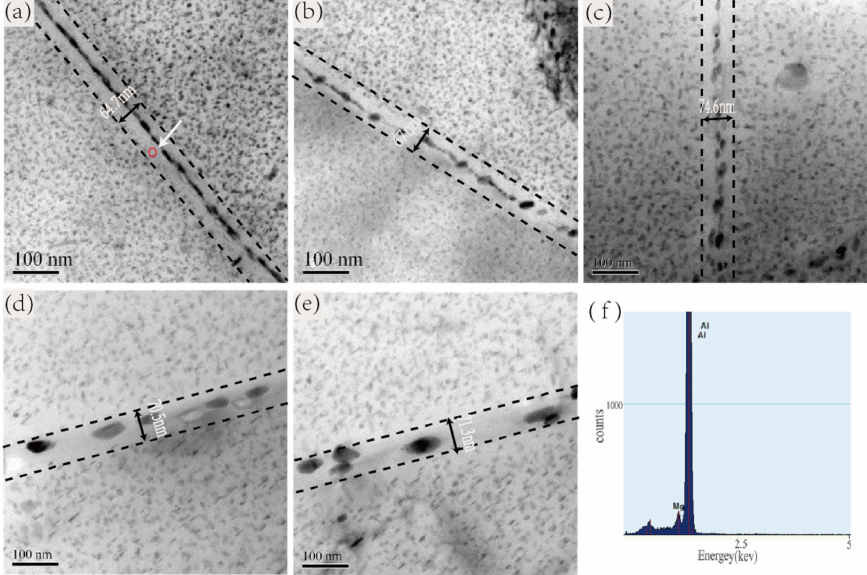
Figure 4. Grain boundary precipitation phase of the alloys: ( a ) Alloy 1, aging 61 h; ( b ) Alloy 2, aging 69 h; ( c ) Alloy 3, aging 81 h; ( d ) Alloy 4, aging 89 h; ( e ) Alloy 5, aging 90 h; ( f ) the energy spectrum at the dotted line of Alloy